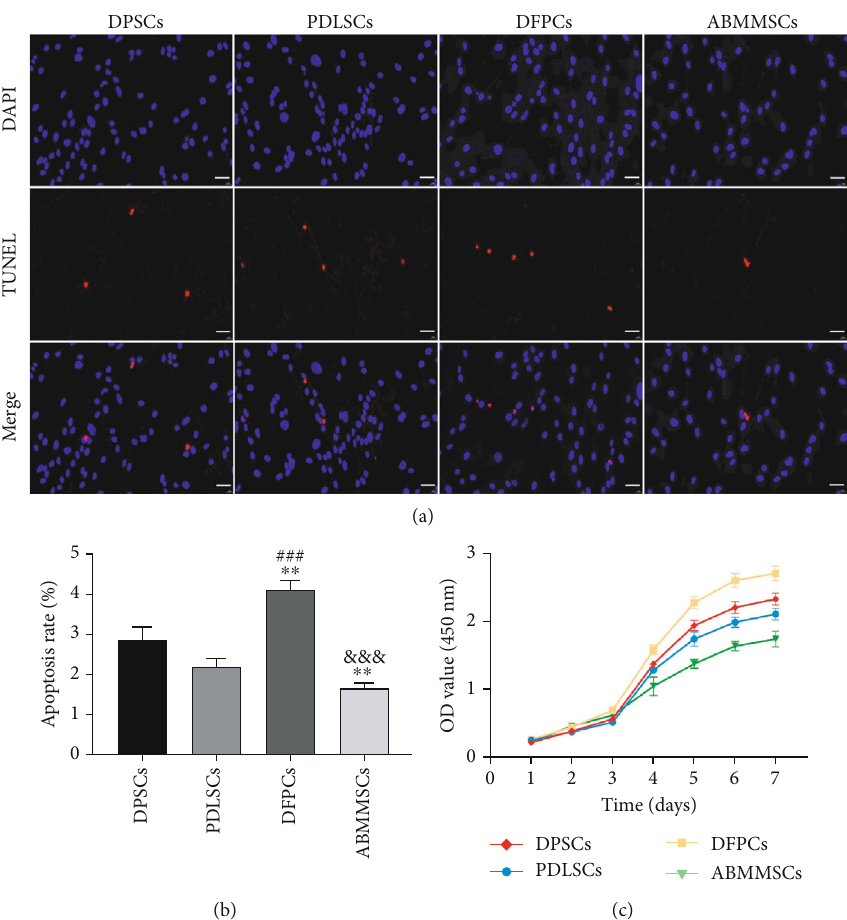
Figure 2: Apoptosis and proliferation rates of DPSCs, PDLSCs, DFPCs, and ABMMSCs. (a) TUNEL staining of DPSCs, PDLSCs, DFPCs, and ABMMSCs at P3 ( scalebar = 50 μ m). (b) The apoptosis rate of DPSCs, PDLSCs, DFPCs, and ABMMSCs at P3. (c) The proliferation rate of DPSCs, PDLSCs, DFPCs, and ABMMSCs at P3 ( ∗ p < 0 : 05 , ∗∗ p < 0 : 01 , and ∗∗∗ p < 0 : 001 vs. DPSCs; # p < 0 : 05 , ## p < 0 : 01 , and ### p < 0 : 001 vs. PDLSCs; & p < 0 : 05 , && p < 0 : 01 , and &&& p < 0 : 001 vs. DFPCs; † p < 0 : 05 , †† p < 0 : 01 , and ††† p < 0.001 vs.